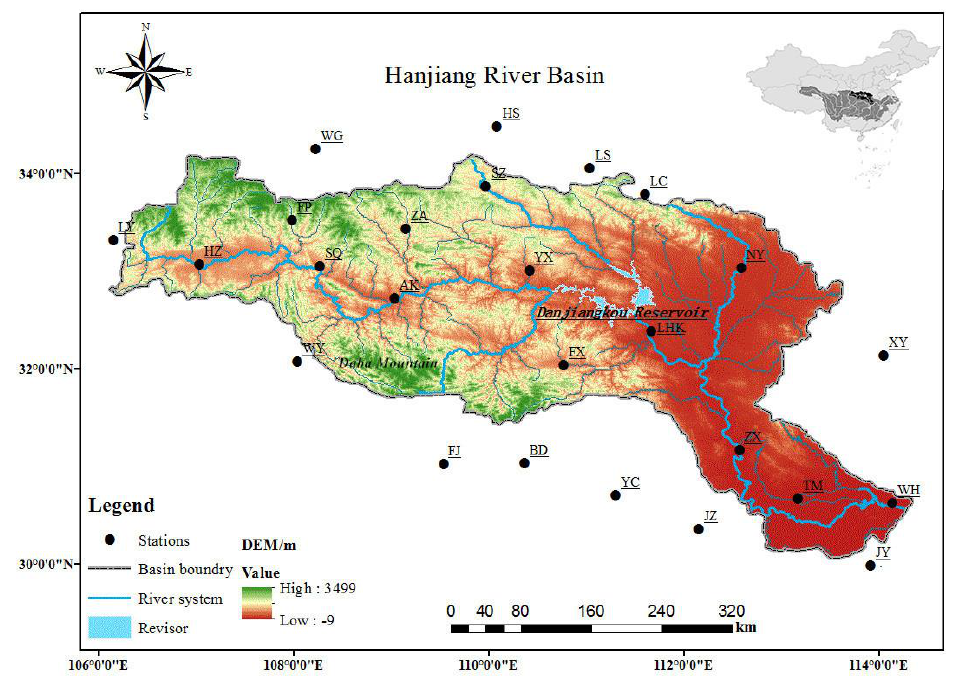
Figure 1. The Hanjiang River Basin and meteorological stations.